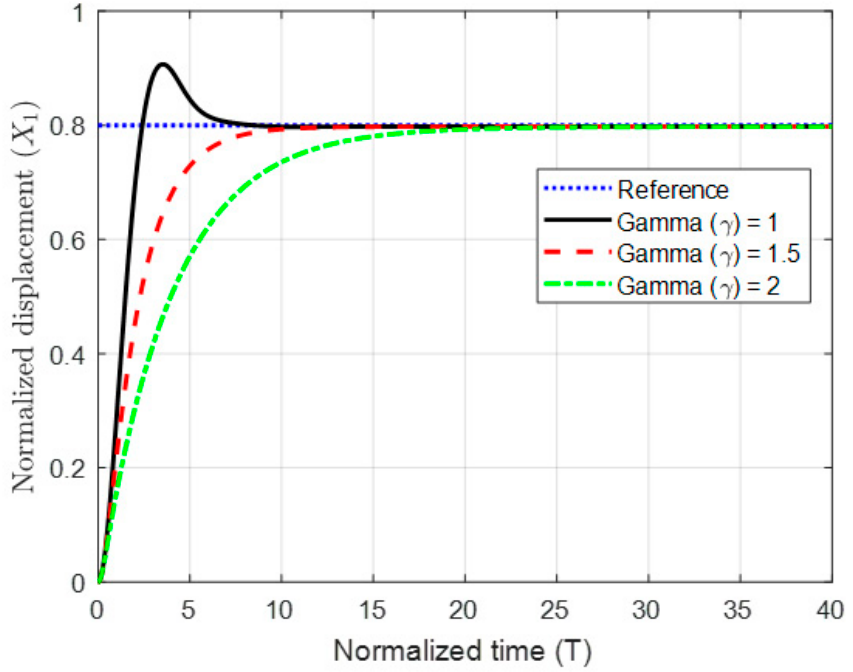
Figure 12. The normalized displacement with different coupling terms at a gap reference of 0.8 and damping ratio ζ = 0.01.